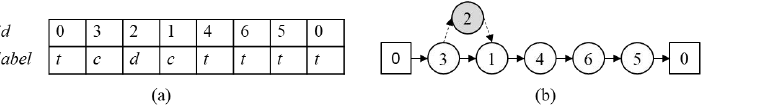
Figure 2. Representative solution: ( a ) represents the solution corresponding to the graph presented in ( b